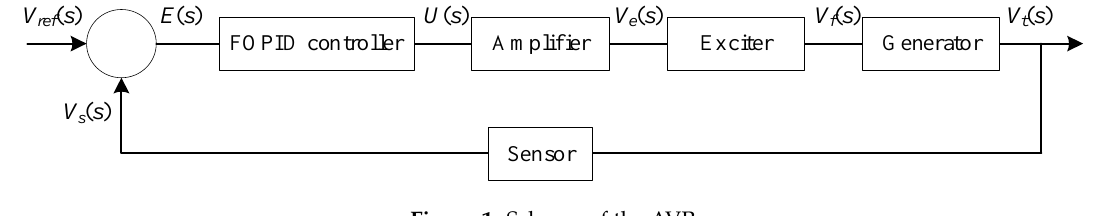
Figure 1. Scheme of the AVR.